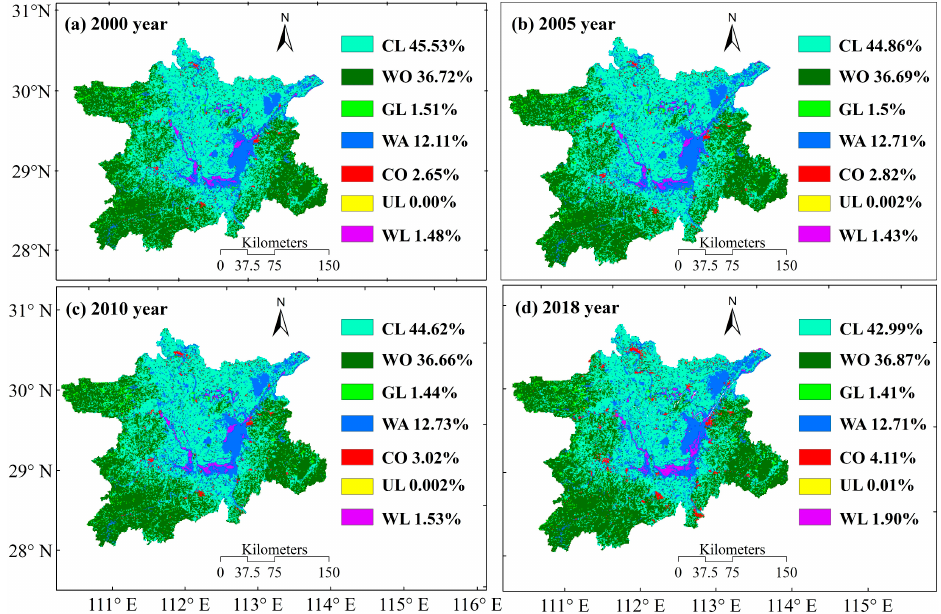
Figure 2. Spatial distribution and percentage of land use in the Dongting Lake.